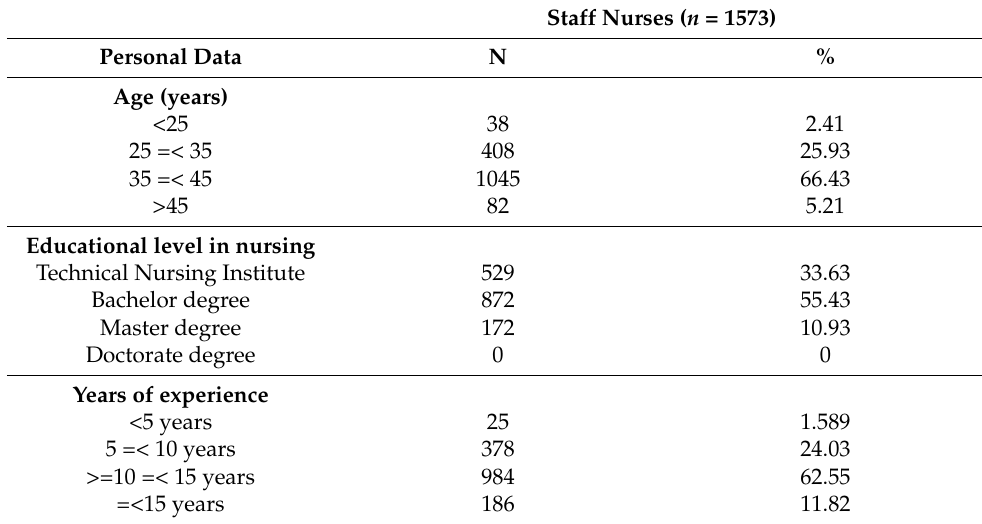
Table 3. Personal data of studied staff nurses ( n = 1573).